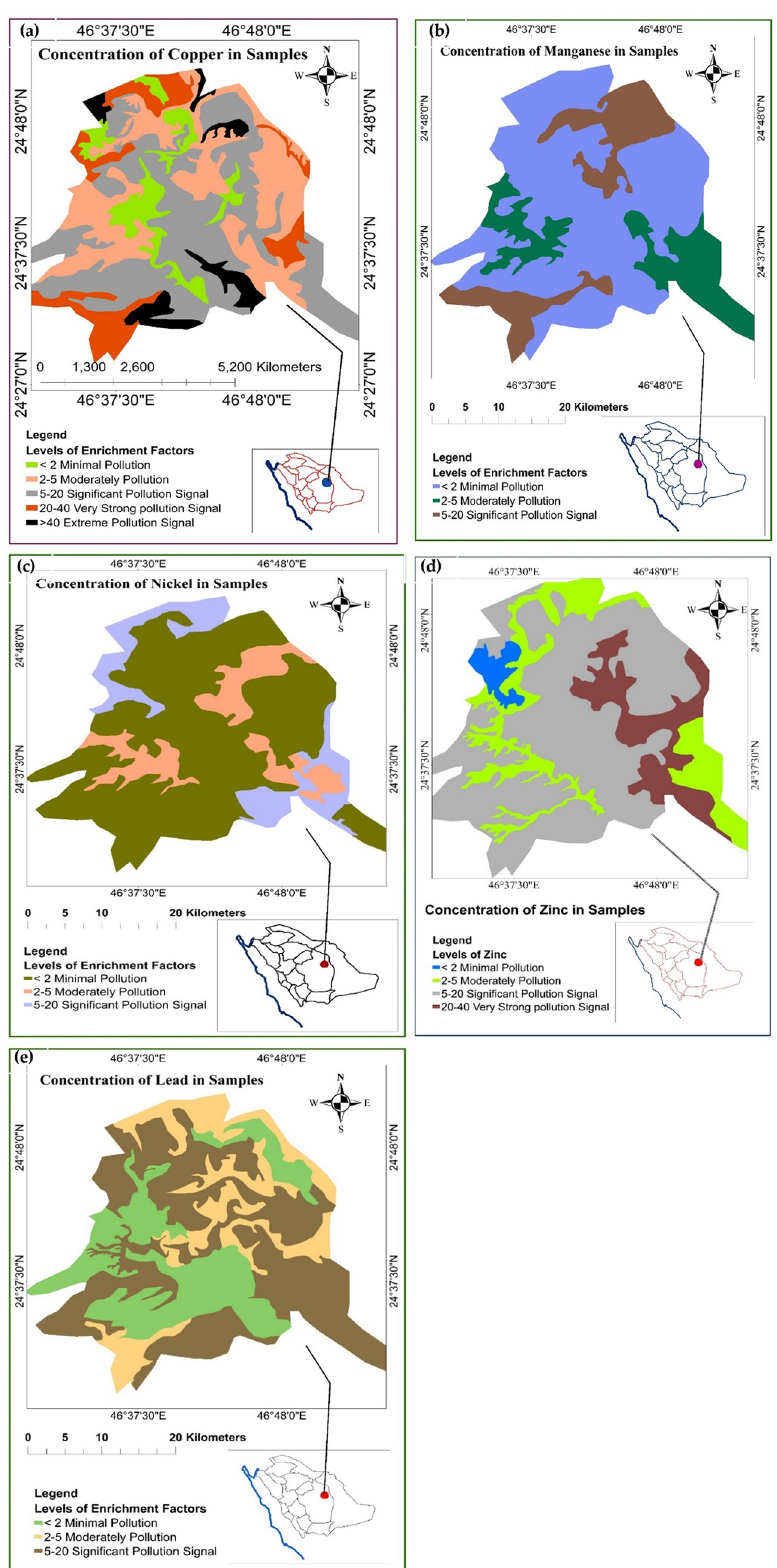
Fig 2. Levels of Enrichment Factors of (a) Copper (b) Manganese (c) Nickel (d) Zinc and (e) Lead in dust samples. https://doi.org/10.1371/journal.pone.0261957.g002 PLOS ONE | https://doi.org/10.1371/journal.pone.0261957 January 6,